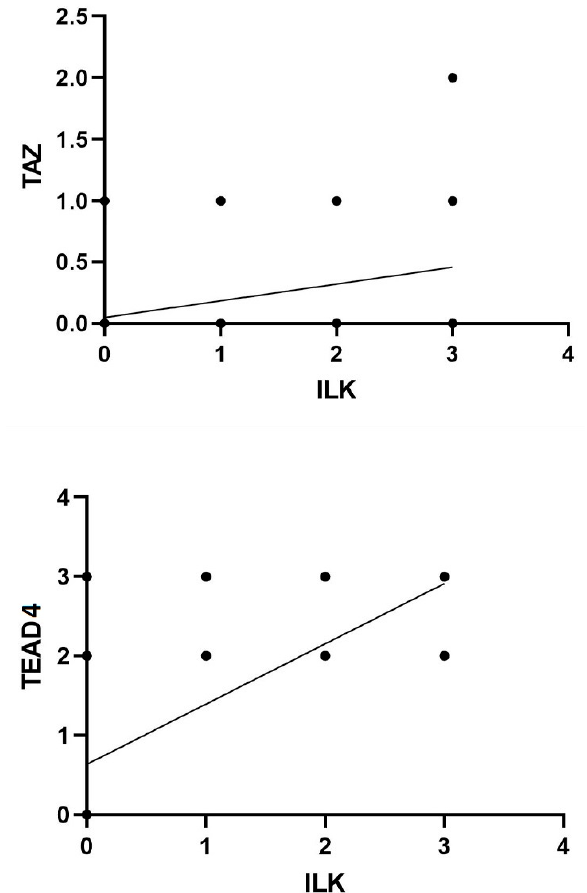
Figure 3. Plots depicting the correlation between ILK and expression of YAP, TAZ and TEAD4 in fibroblasts.